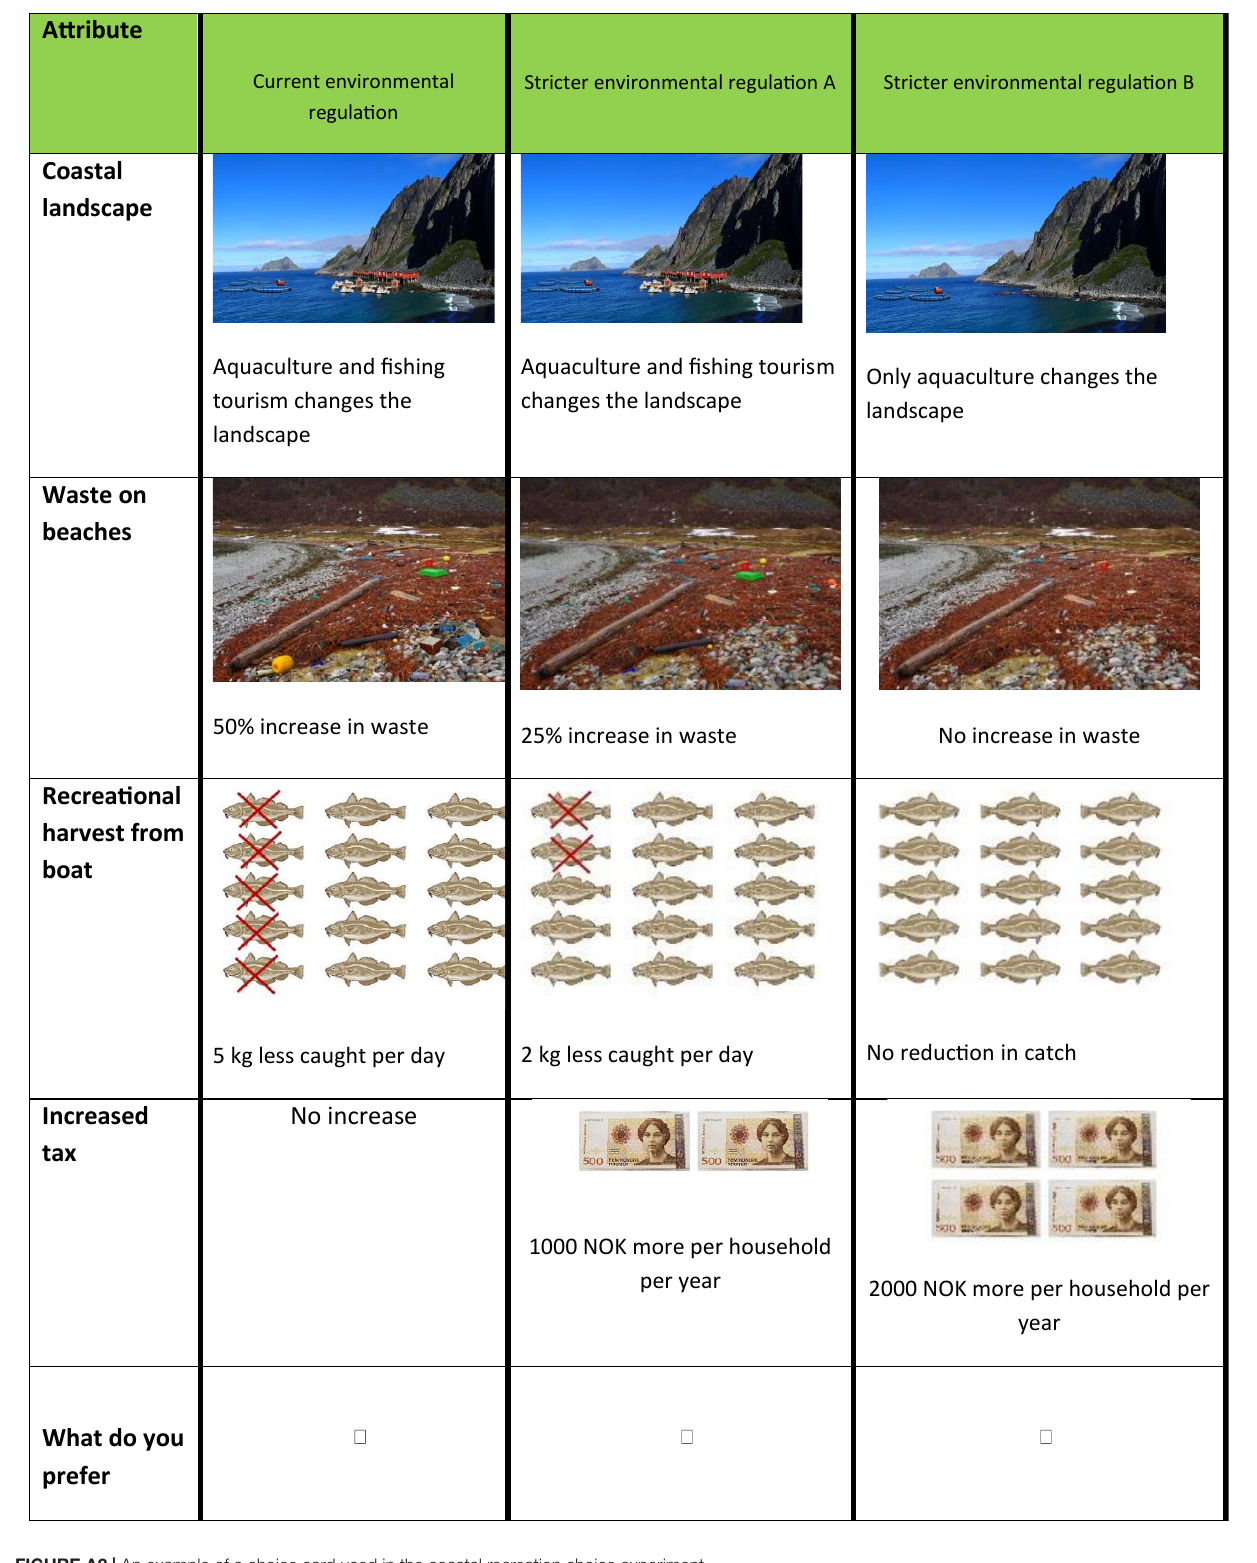
Frontiers in Marine Science |